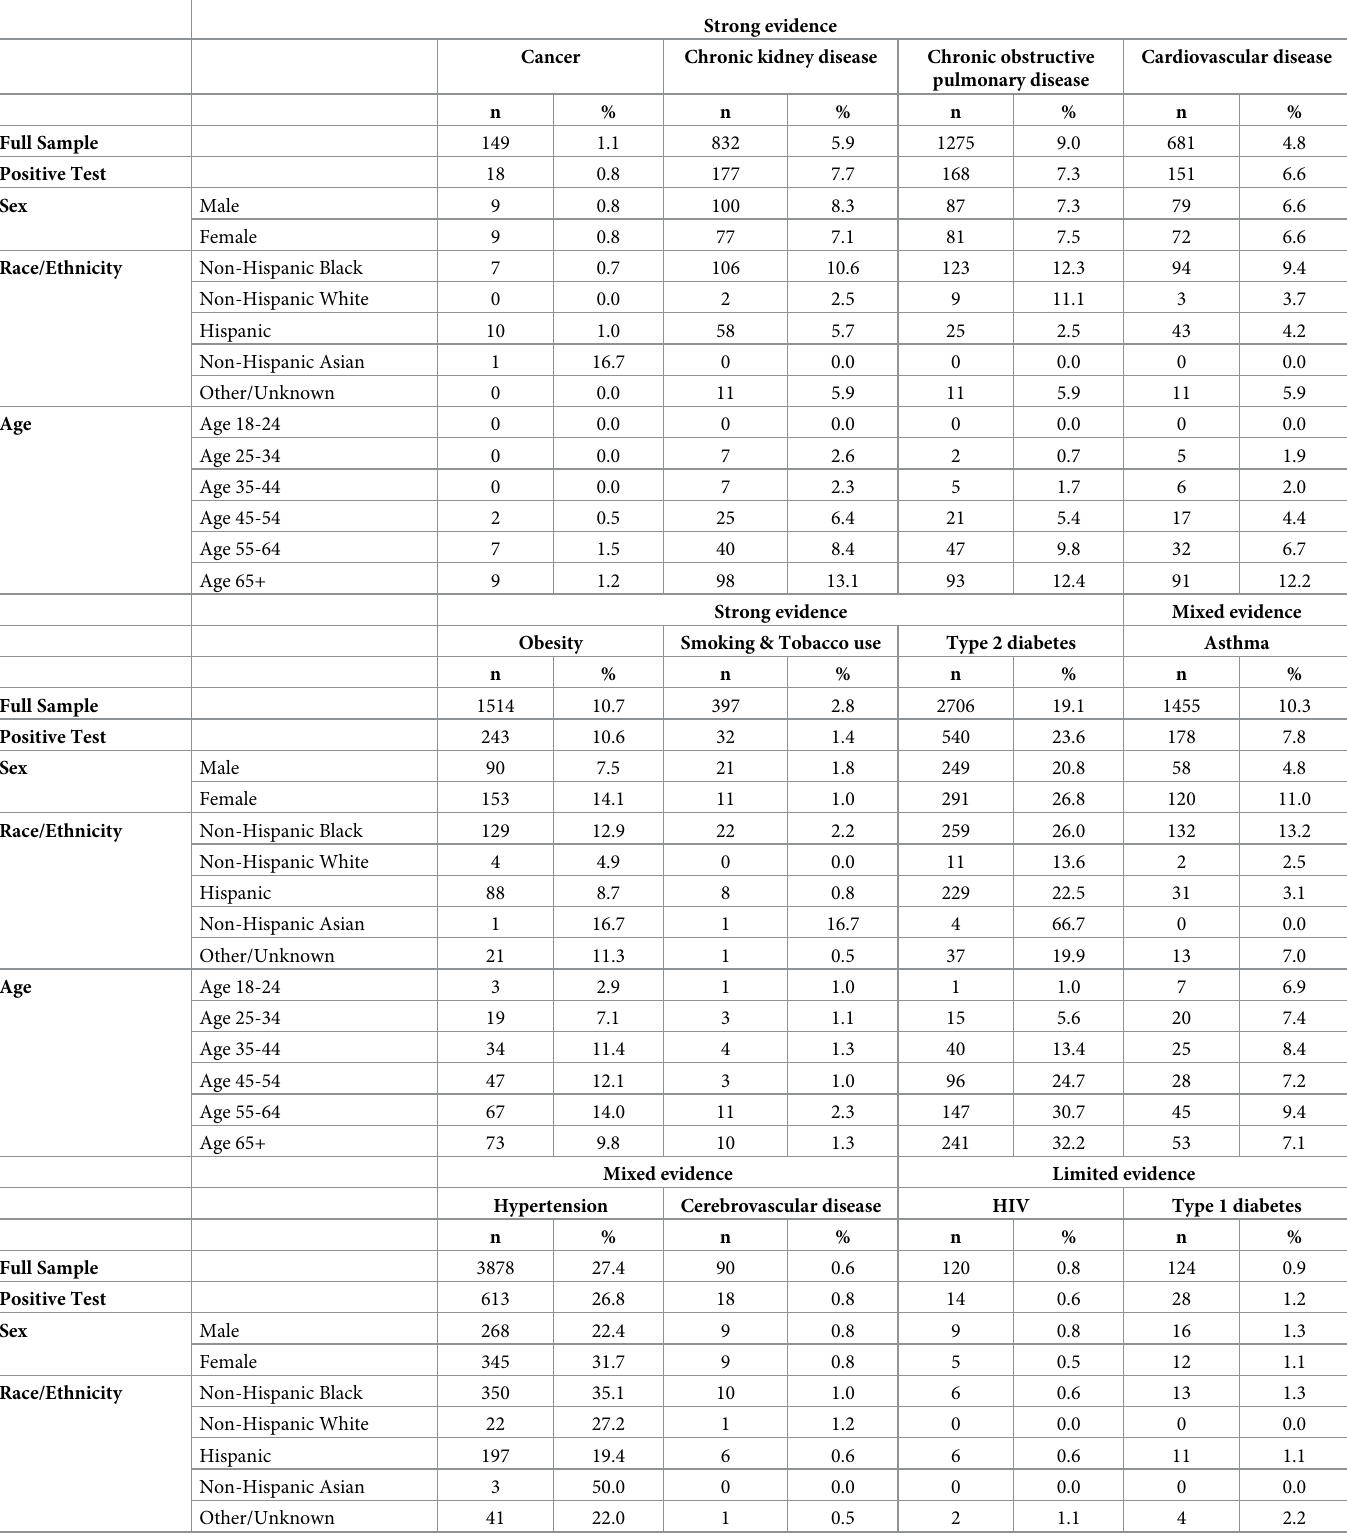
Table 2. Comorbidities, ventilator use, and length of stay by result, sex, race, and age.